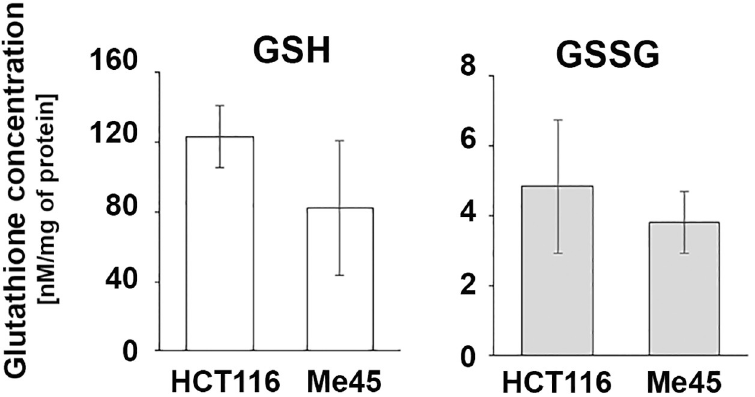
Fig 6. Levels of reduced (GSH) and oxidized (GSSG) glutathione in HCT116 and Me45 cells. Data show the mean and SD of 3 independent experiments.